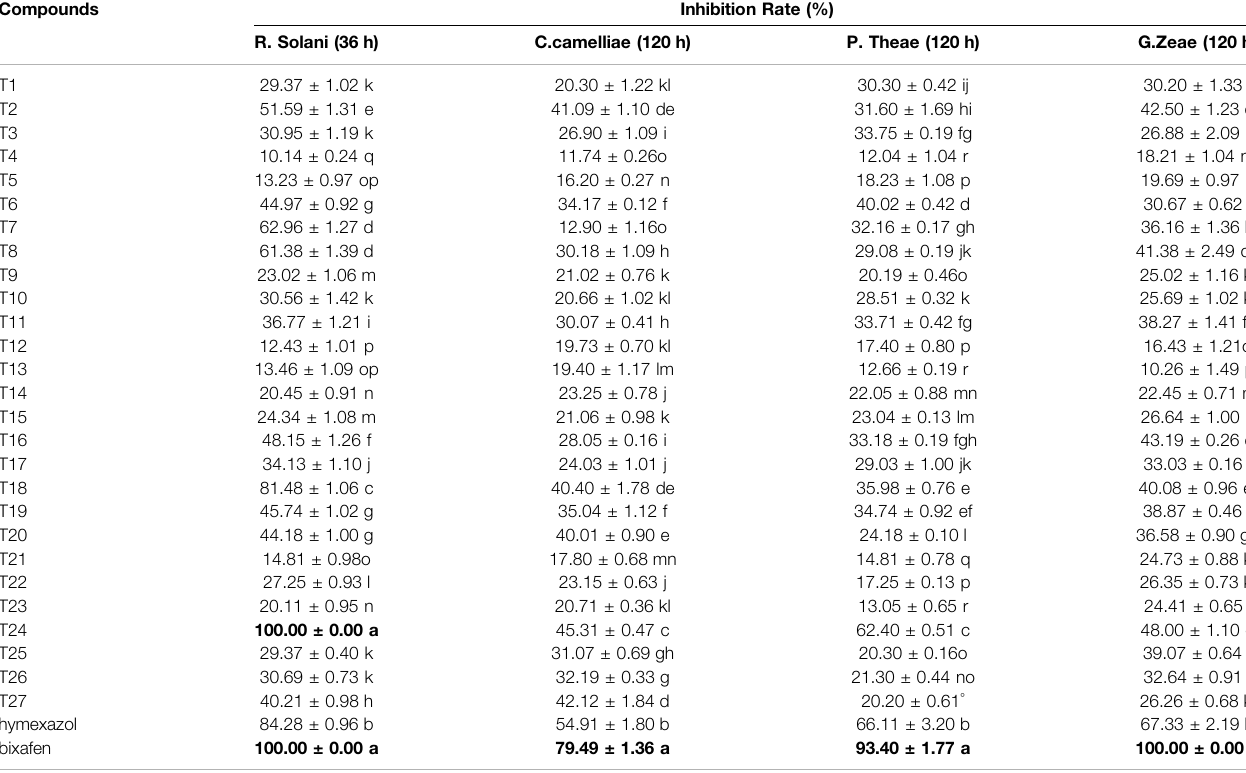
TABLE 1 | Inhibition rate in vitro of target compounds T1-27 at 50 μ g/ml.